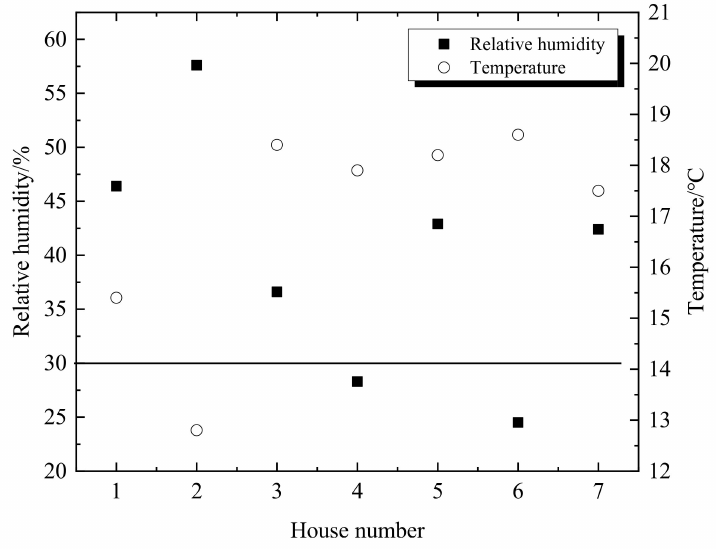
Figure 3. Indoor temperature and relative humidity during heating